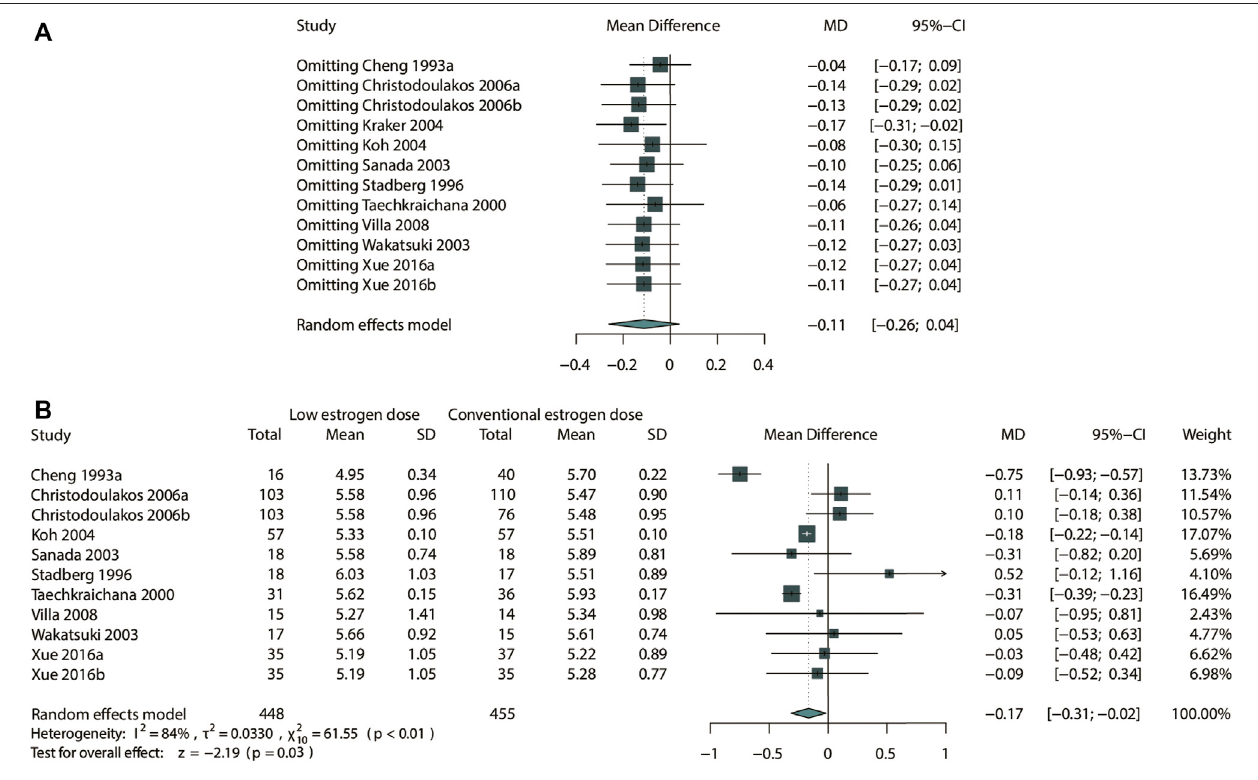
FIGURE 9 | Sensitivity analysis for TC in the subgroup of low-dose estrogen. Sensitivity analysis suggested that while omitting the study Kraker 2004, low-dose estrogen could decrease TC signi fi cantly (MD: − 0.17 mmol/L, 95% CI: − 0.31 to − 0.02 mmol/L). (A) Sensitivity analysis; (B) forrest plot after omitted study Kraker 2004.